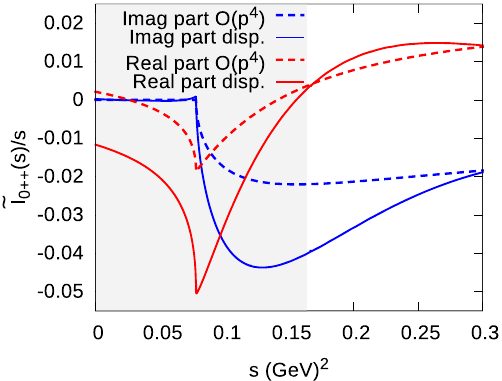
Fig. 4 Dispersive calculation of the isospin-violating component of the η → πγγ S -wave amplitude (divided by s ), compared to the chiral result at order p 4 . The shaded area shows the physical